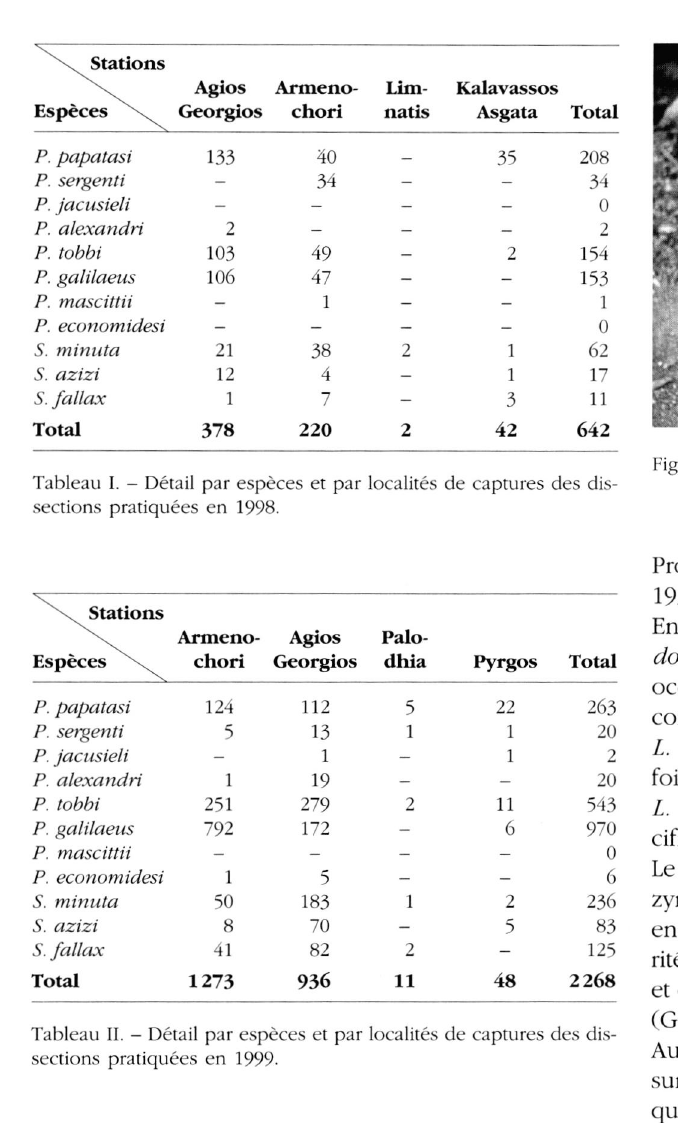
Tableau II. - Détail par espèces et par localités de captures des dis sections pratiquées en 1999.